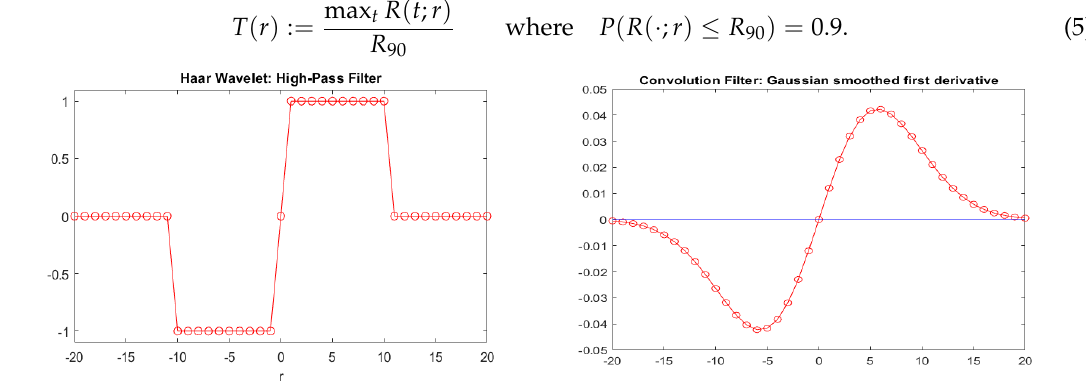
Figure 1. Left: The Haar wavelet high-pass convulution filter (of width r = 10). At each point, this convolution filter computed the difference between the 10-point averages on the right and left of the central point. So, in this sense, it is similar to a derivative, except that we compared averages, rather than point values; Right: Example of convolution filter G (cid:48) r (Gaussian smoothed first derivative). In this case, the filter has a radius of r = 20. The filter can be interpreted as a smoothed version of the the Haar wavelet on the left. Since scaled this filter (i.e., varying r ) to elicit the response at different scales, this type of filtering is akin to (Haar) wavelet analysis.